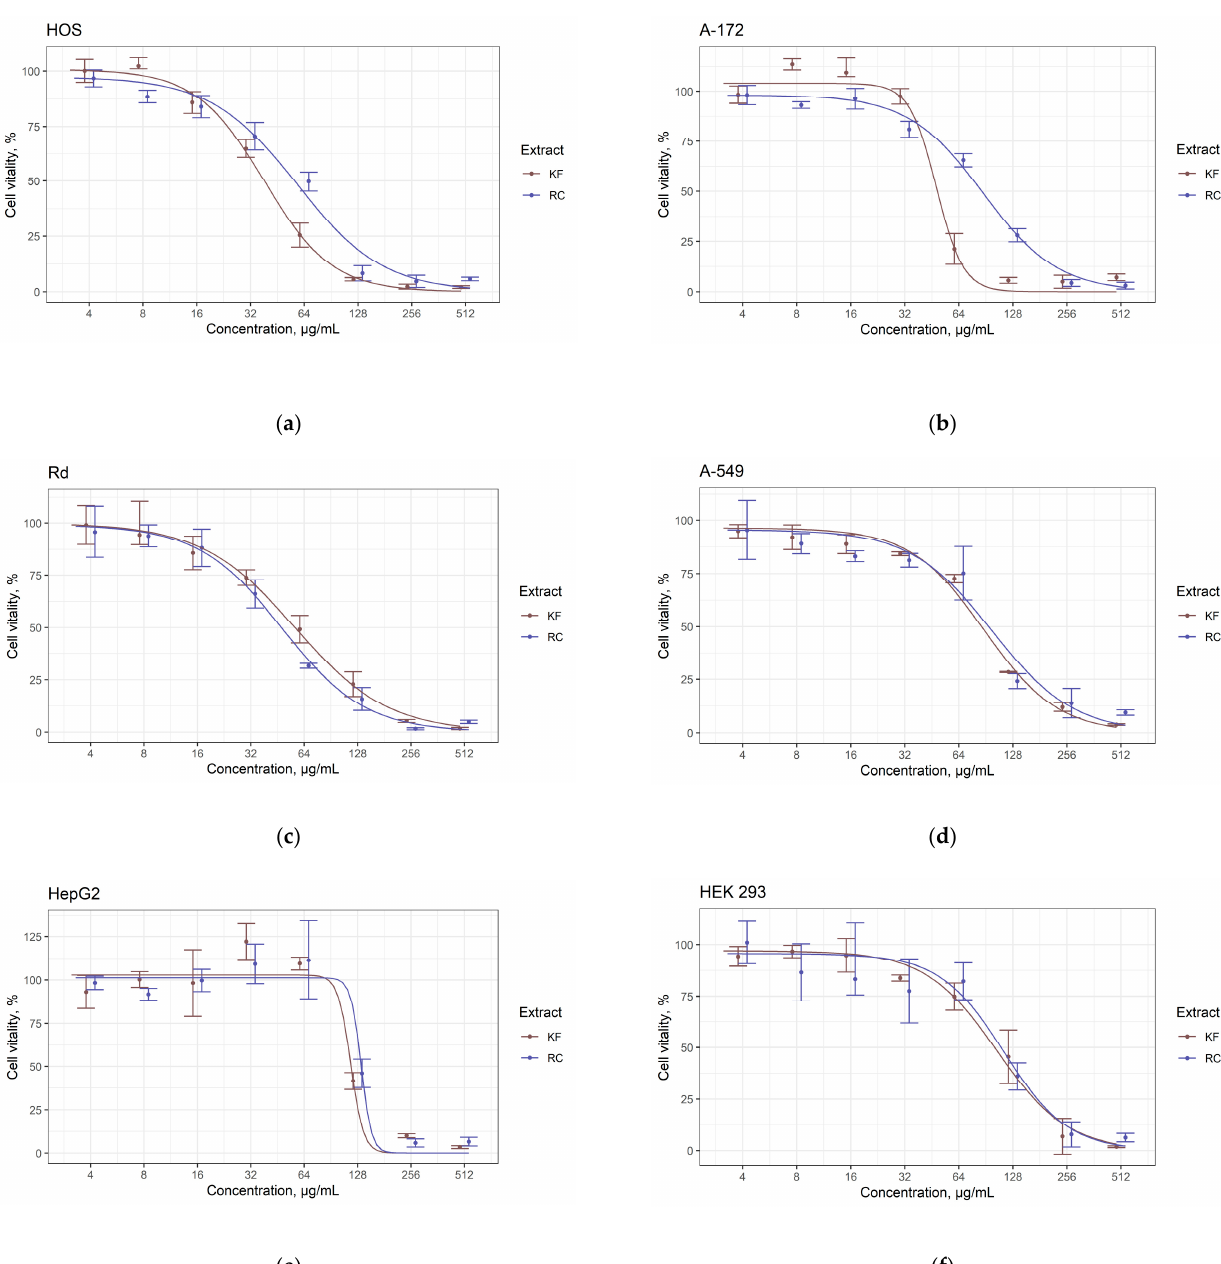
Figure 2. Evaluation of the effect of kudzu flower (KF) and red clover (RC) extracts on the viability of human osteosarcoma HOS cells ( a ), glioblastoma A-172 cells ( b ), human embryonic rhabdomyosarcoma Rd cells ( c ), human lung carcinoma A-549 cells ( d ), human liver carcinoma HepG2 cells ( e ) and human embryonic kidney cells HEK-293 ( f ), (mean ± CI 95 ). A previous study reported that Pueraria lobata extracts reduced ethanol-induced cytotoxicity in HepG2 Cell (57% cell viability), and exhibited cytotoxicity against breast cancer (MCF7) and A549 cancer cell lines [69]. Another research on another Pueraria species ( Pueraria tuberosa ) revealed significant cytotoxic of its extract against HepG2 cell lines with IC 50 (69 µ M) [70] and human ovarian cancer cell line A2780 [22]. Similarly, RC extract was documented to show cytotoxicity against glioblastoma multiforme cell line (U87MG) [24], and human breast cancer cell lines (MCF-7 and MDA-MB-231) [71,72]. To our knowledge, no previous reports on the cytotoxicity of RC on GOELL cancer cell